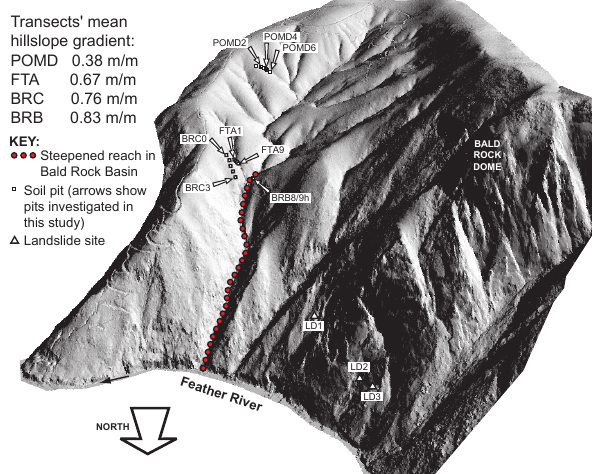
Figure 3. Shaded relief of Bald Rock basin derived from lidar (1m resolution) data, showing the location of the soil and landslide sites. Horizontal length of steepened reach is ∼